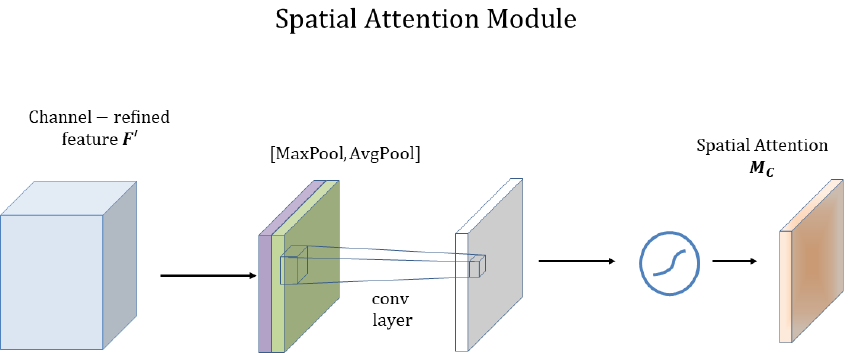
Figure 5. Illustration of spatial attention module in CBAM.